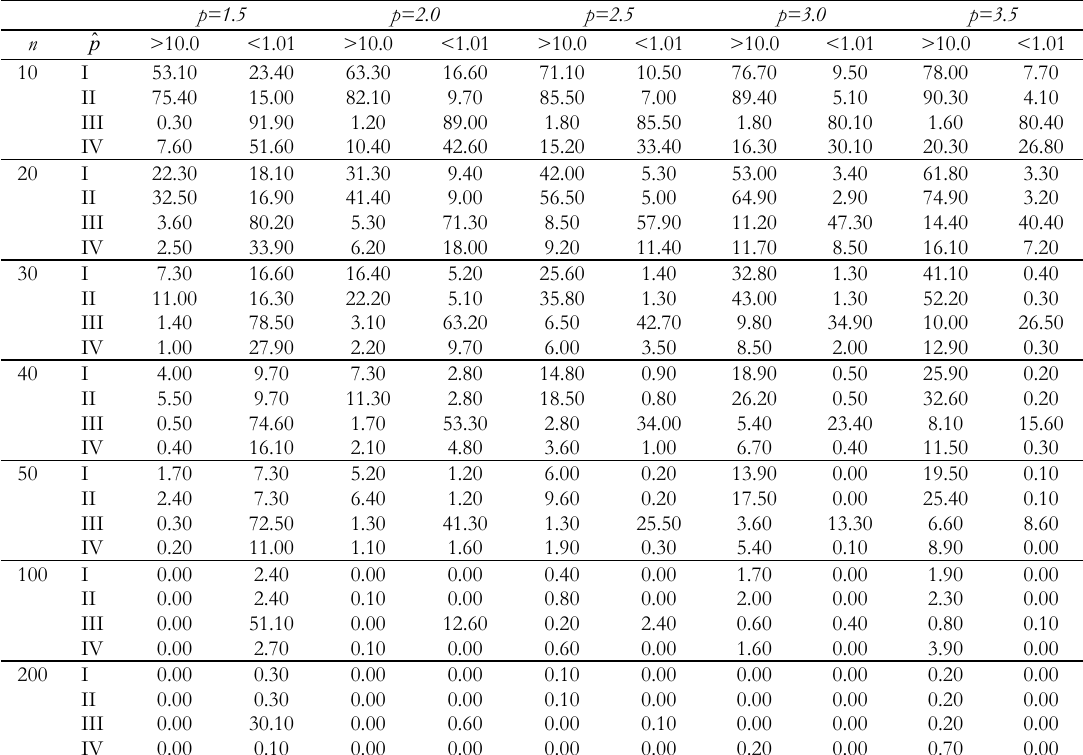
Percentages of samples that present estimates of the structure parameter p greater than 10.0 or lower than 1.01 for the four used methods (I=whole log-likelihood, II=profile log-likelihood, III=conditional profile log-likelihood, IV=method based on the index ˆ VI